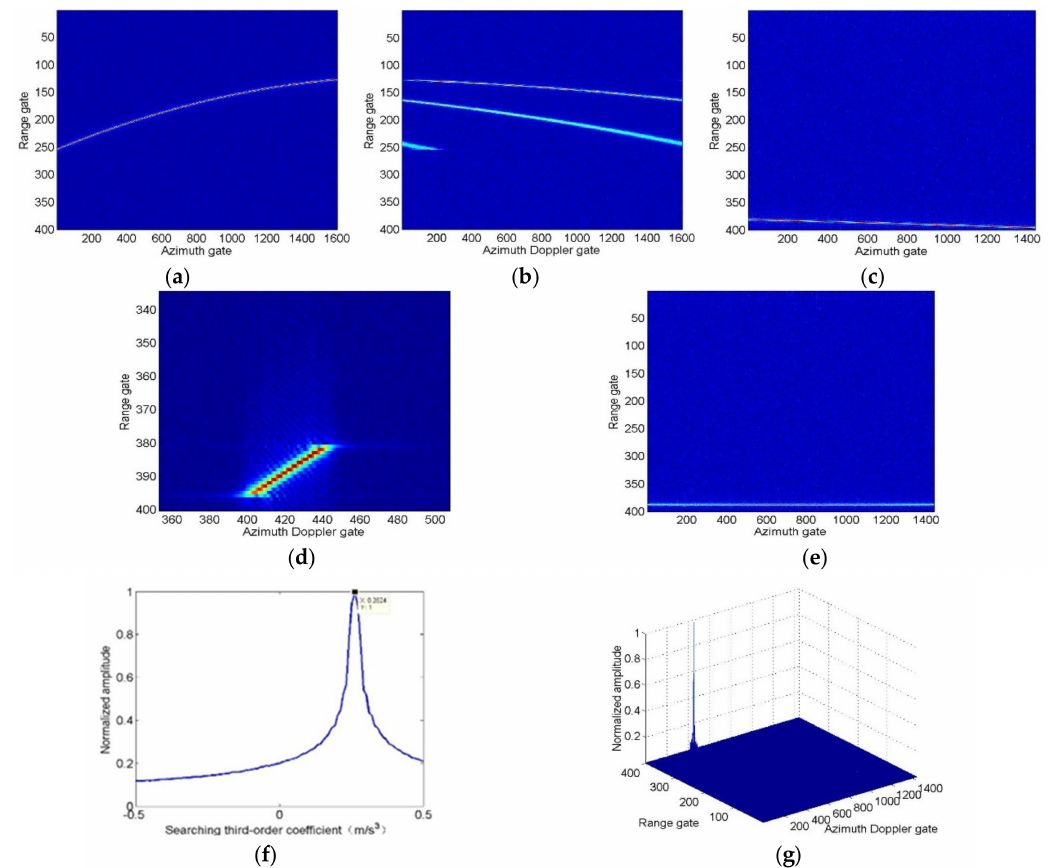
Figure 4. Simulation results of Example 1. ( a ) Target trajectory after range compression. ( b ) Corresponding target Doppler spectrum. ( c ) Target trajectory after DPT. ( d ) Corresponding target Doppler spectrum after DPT. ( e ) Result after KT. ( f ) Searching result of third-order coefficient. ( g ) Focusing result of the proposed